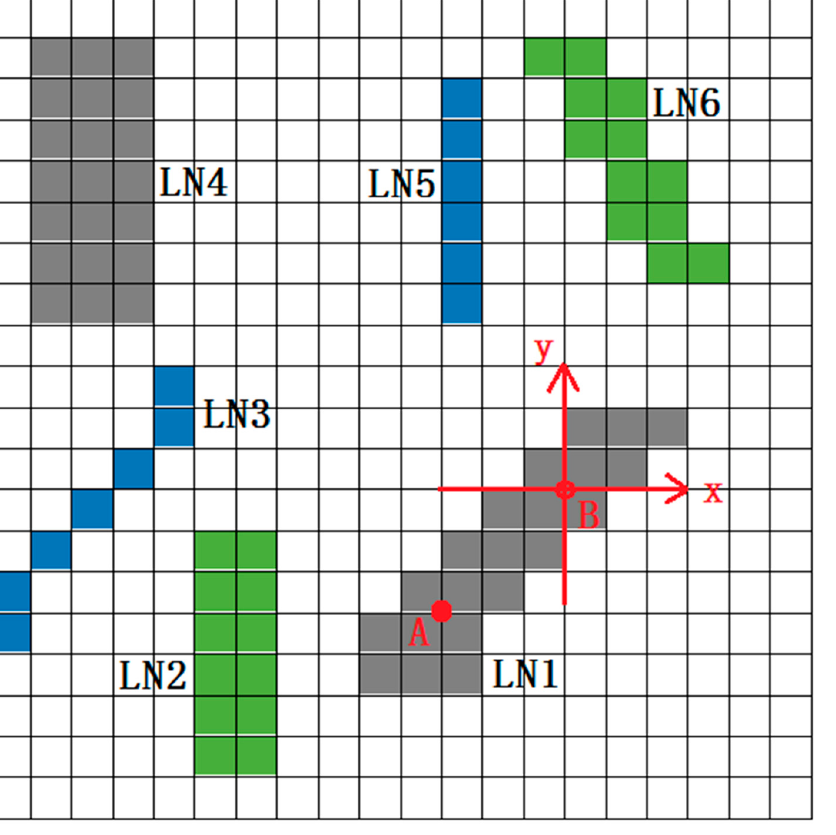
Figure 2. A schematic of sea ice geometry. The full domain is composed of 20 × 20 pixels. The enclosed area with same color denotes one of sea ice leads. The red lines with arrows denote orthogonal coordinates used in sea ice lead width identification. A and B denote the locations of the original point of orthogonal coordinates. LN1–6 denotes six sea ice leads.